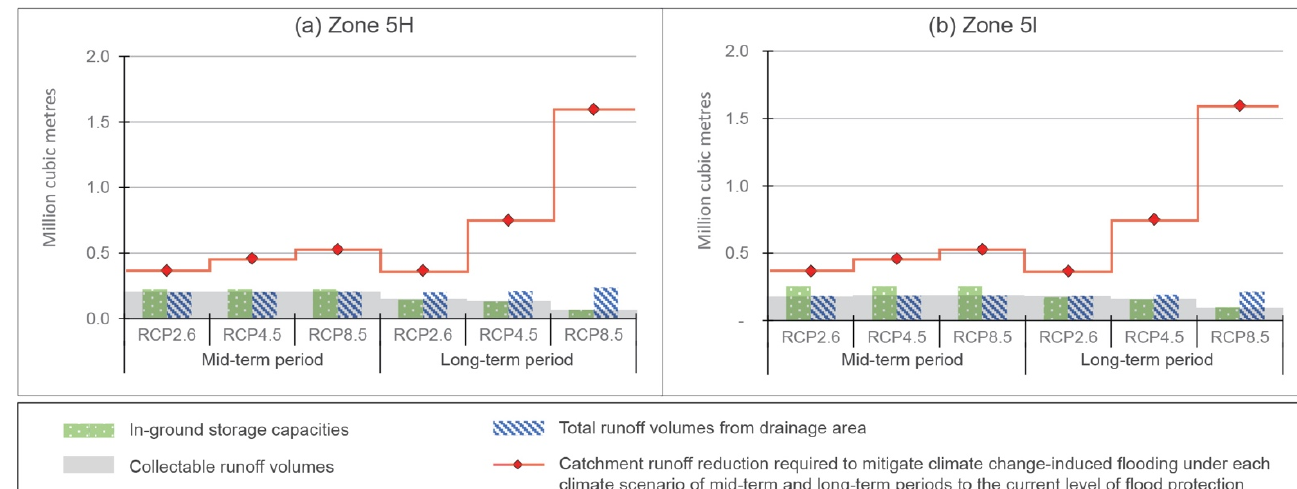
Figure 9. The collectable runoff volumes of Zone 5H and 5I (shaded in grey) are equivalent to their runoff volumes (blue bars) over the mid-term under all climate scenarios. Runoff volumes will exceed storage capacities (green bar) in the long term under all climate scenarios. However, collected runoff volumes are not sufficient to reduce the impacts of the minor climate change scenario in the mid-term (the levels indicated by the red lines).